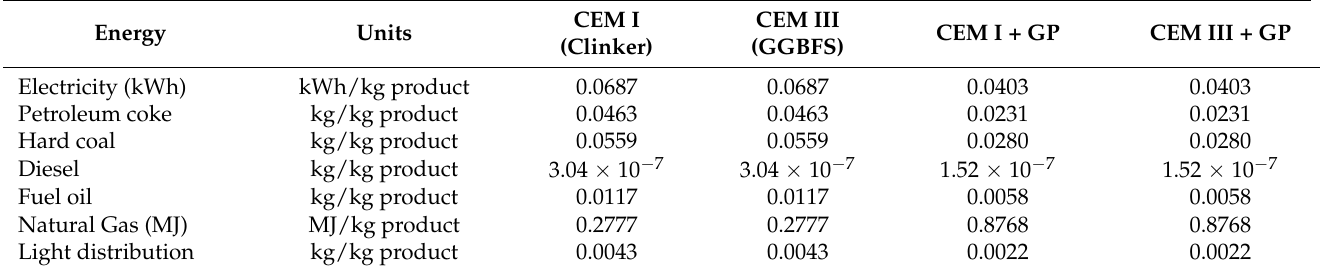
Table 5. Energy consumption inventory input and calculations.